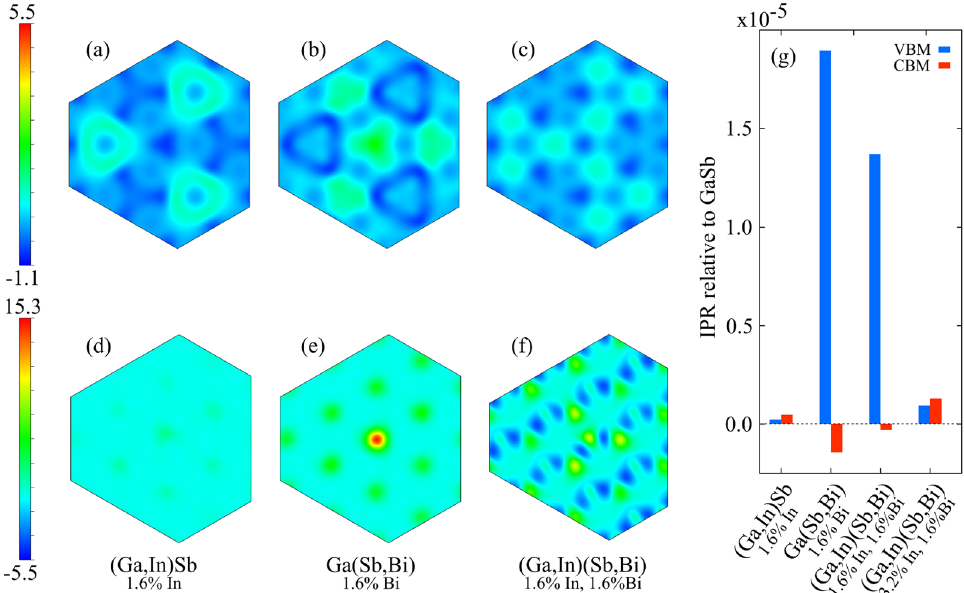
Figure 2. Electron localisation, presented as a difference in partial charge densities. Panels show a 2D cross section along the 111 plane, which crosses through the closest vicinity of the substituted atoms, located at the center of the unit cell. Top row (panels a – c ) correspond to the conduction band minimum (CBM) of (Ga,In)Sb, Ga(Sb,Bi), and (Ga,In)(Sb,Bi) respectively. Bottom row (panels d – f ) corresponds to the valence band maximum (VBM) for the same materials. The unit of the scale is 10 − 11 . Panel ( g ) shows inverse participation ratio (IPR) relative to that of GaSb for VBM and CBM as a function of composition.